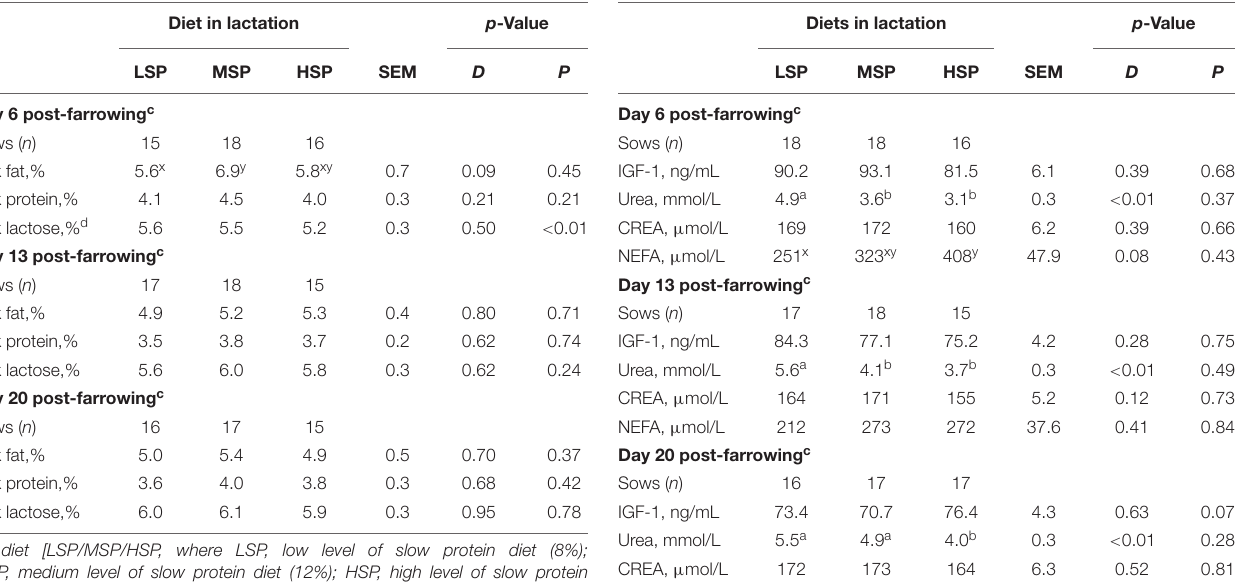
TABLE 7 | Total nitrogen loss, fecal nitrogen output, and urinary nitrogen output between Days 2 and 21 post-farrowing (LSmeans ± SEM). Diets in lactation p -Value